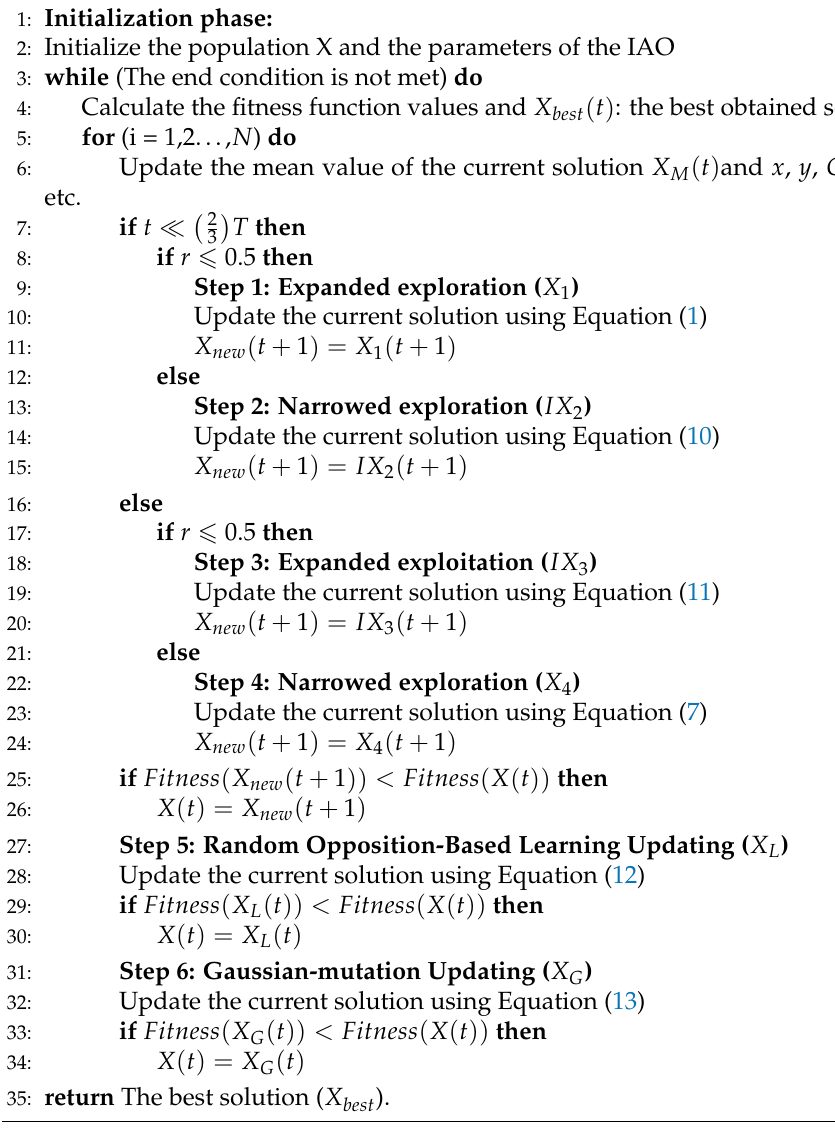
Algorithm 1 Improved Aquila